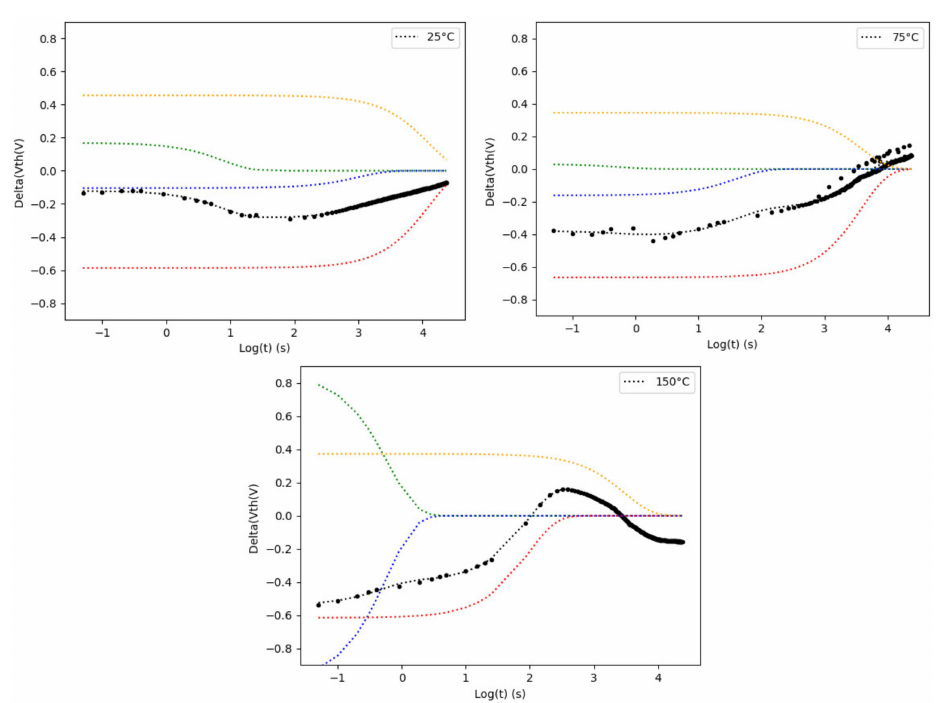
Figure 5. Example of experimental Vth shift at 25 ◦ C, 75 ◦ C and 150 ◦ C (black point) and its recovery in the time after stress (Design A wafer 2). Color curves are used to rebuild experimental Vth recovery. It is clear, especially in Figure 5 at 75 ◦ C, that the four different slopes of the DeltaVth curve in the function of time (black dash) can be modelized by a sum of a minimum of four decreasing exponentials (color dash). Each exponential characteristic represents a trap energy level. Therefore, it is possible to reproduce the experimental curve (black curve) using two levels of initial positive charges (yellow and green curve) combined with two initial negative charges (blue and red